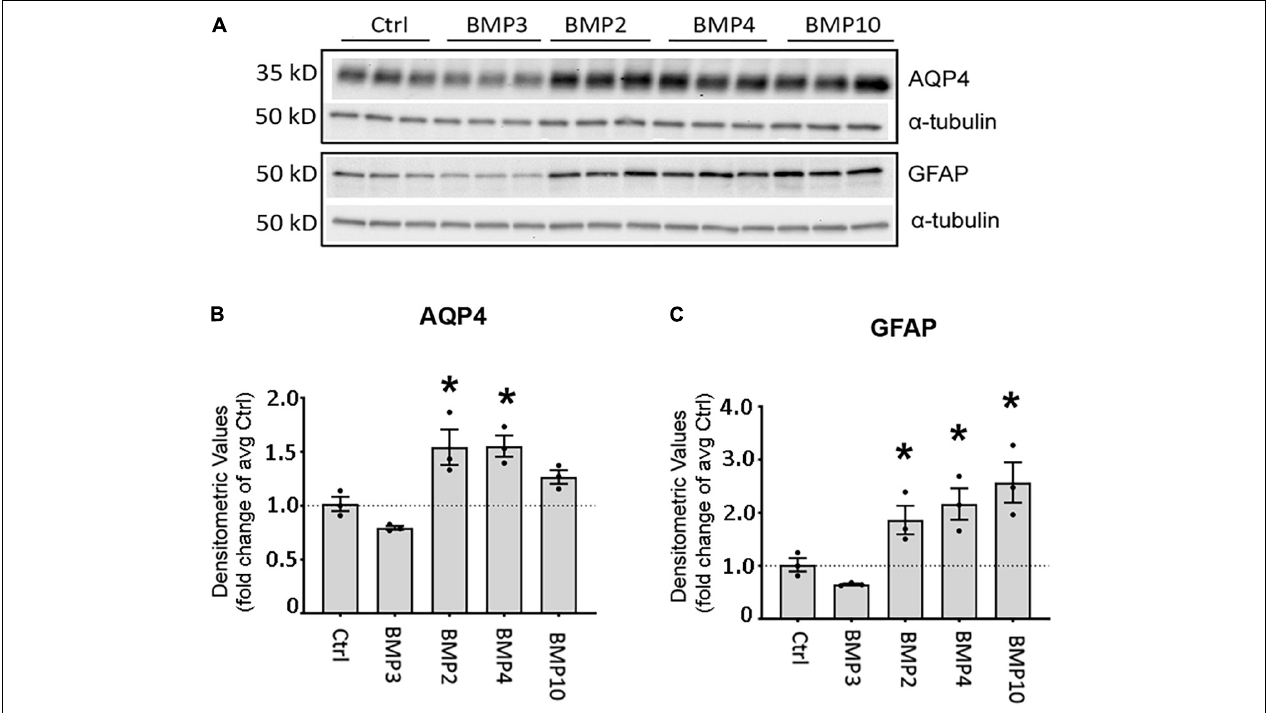
FIGURE 3 | Canonical BMPs increase expression of AQP4 and GFAP protein in astrocytes. (A) Immunoblot assessment of AQP4 and GFAP protein lysates after treatment with BMPs for 72 h validates upregulation on the protein level only in cells treated with BMPs known to activate Smad1/5/9 (BMPs –2, –4, –10) and not the non-canonical BMP3. (B,C) Densitometric analysis of the immunoblots confirms that both AQP4 and GFAP are significantly upregulated by BMP2, BMP4 and BMP10 treatment. Expression shown as fold changes compared to untreated cells (Ctrl). *Sig ANOVA LSD post-hoc test; error bars: SEM; dots: individual sample values; P < 0.05; n =